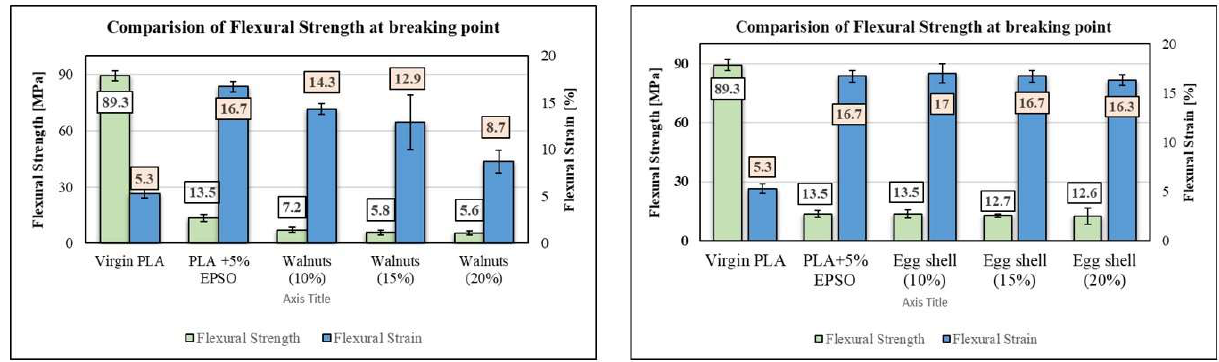
Figure 9. Flexural test result—Flexural strength [MPa] at the breaking point comparison.